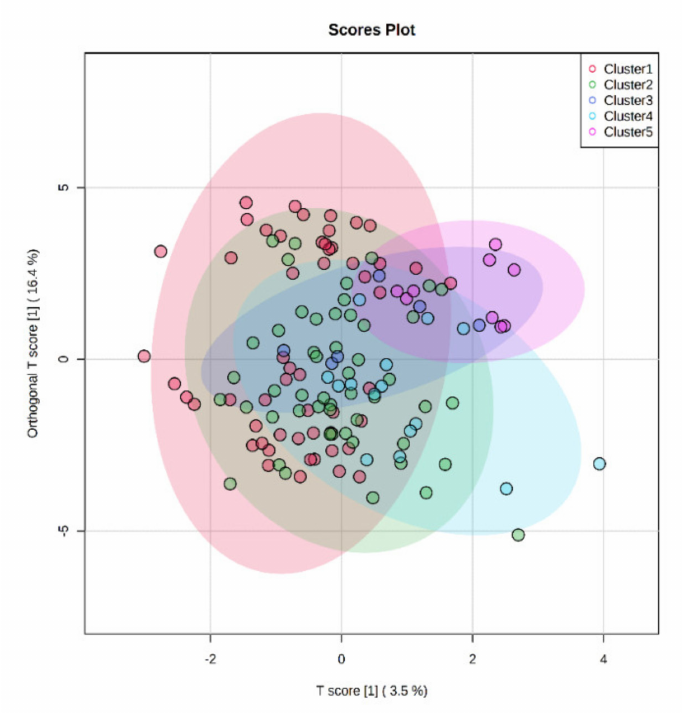
Figure 3. OPLS-DA score plot considering the different milk samples and their cluster, according to the corn silage contamination